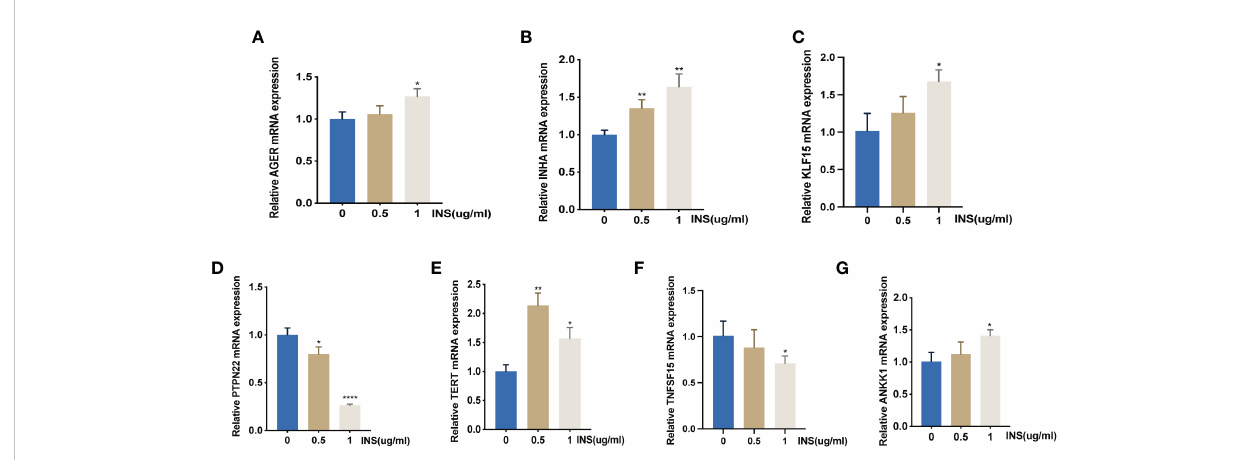
FIGURE 6 qRT-PCR veri fi cation of RNA-Seq analysis of gene expression. *: (A – G) The mRNA expression of AGER, INHA, KLF15, PTPN22, TERT, TNFSF15, and ANKK1 were detected by *: P<0.05, **: P<0.01, ****: P<0.0001 compared to group “ 0 ”